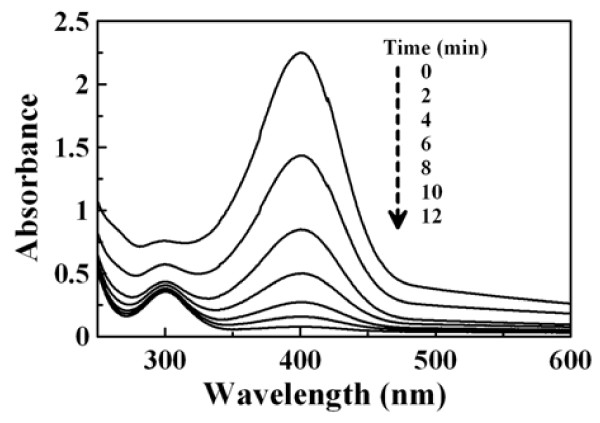
Time-dependent UV/VIS absorption spectra for NaBH4-reduction of 4-NP catalyzed by GAAu-MNP. [Au]0 = 0.295 × 10−2 mg/mL, [4-NP] = 1.5 × 10−4 M, [NaBH4] = 1.5 × 10−2 M, 30°C.